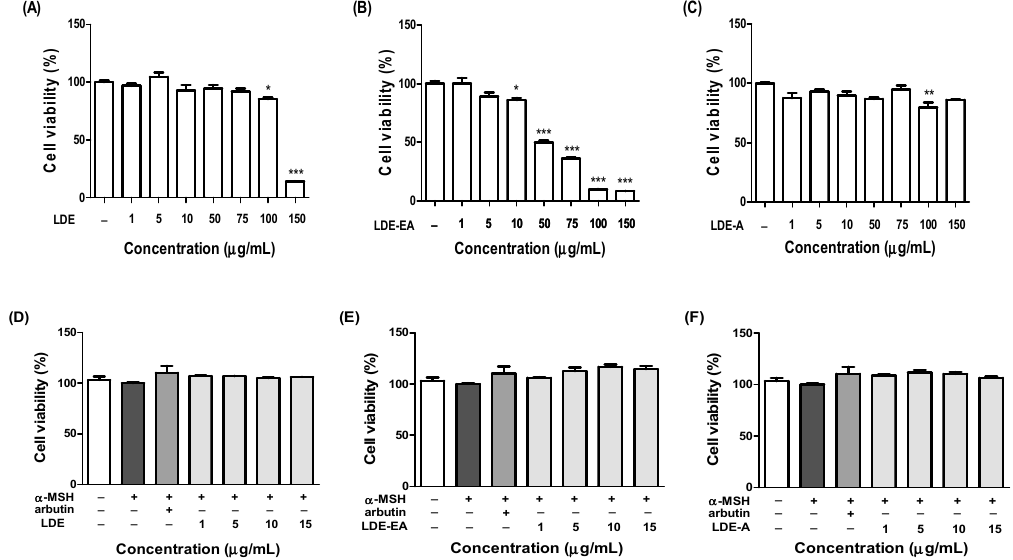
Figure 1. Effect of L. difformis extract on B16F10 melanoma cell viability. Cells were treated with various concentrations of LDE ( A ), LDE-EA ( B ), and LDE-A ( C ) for 24 h, and were then treated with 200 nM α -MSH and 1, 5, 10, and 15 µ g/mL of LDE ( D ), LDE-EA ( E ), and LDE-A ( F ) for 72 h. Arbutin was used as a positive control at a concentration of 1 mM. Cell viability was measured by MTT assay. The results are represented as a percentage of control. Values are represented as the mean ± SEM of three independent experiments; * p < 0.05, ** p < 0.01, and *** p < 0.001 versus control.